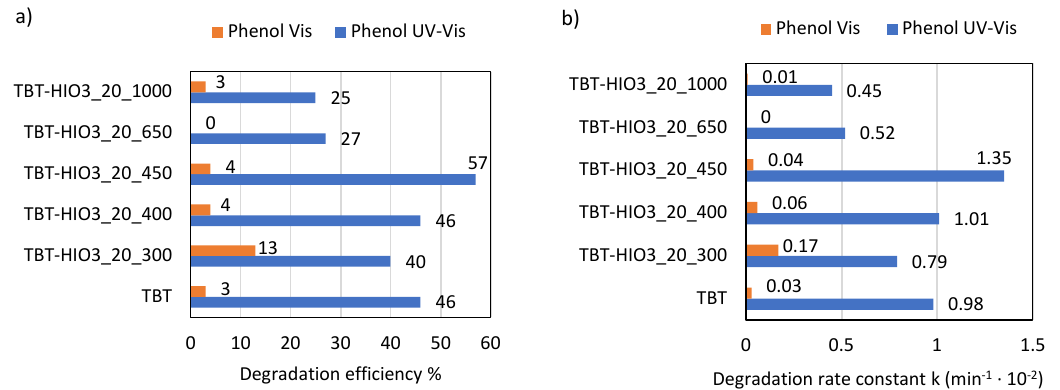
Figure 19. Efficiency of phenol degradation in UV-Vis and Vis light for defective TiO 2 -HIO 3 _20_T photocatalysts, presented as % of degradation (a) and rate constant k (b).